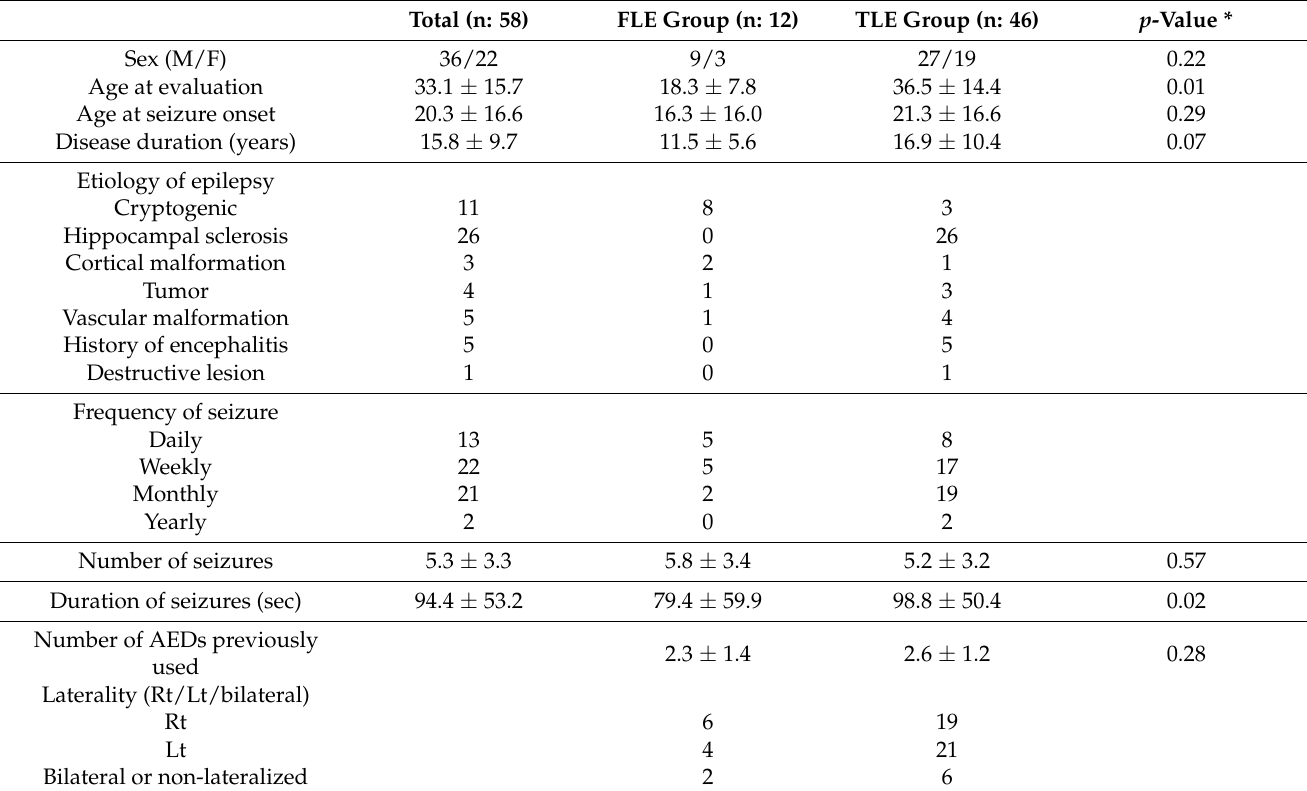
Table 1. Demographical and clinical information of patients in the study